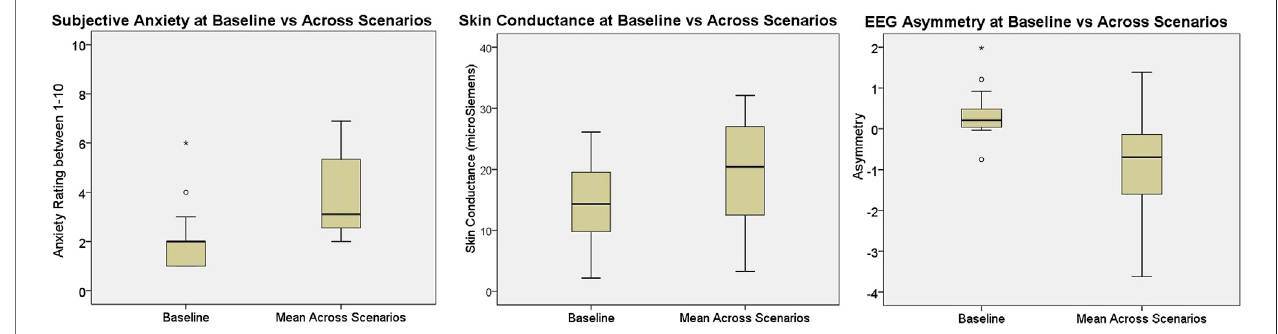
FIGURE5| Boxandwhiskerplotsshowingcomparisons ofbaselinevsacrossscenarios forsubjective,GSRandEEG anxietymetricsforparticipantswithanFSQ score > 15.